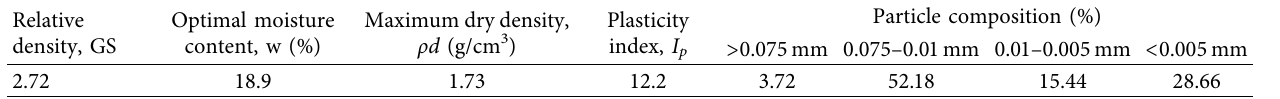
Table 1: Te physical properties of loess.